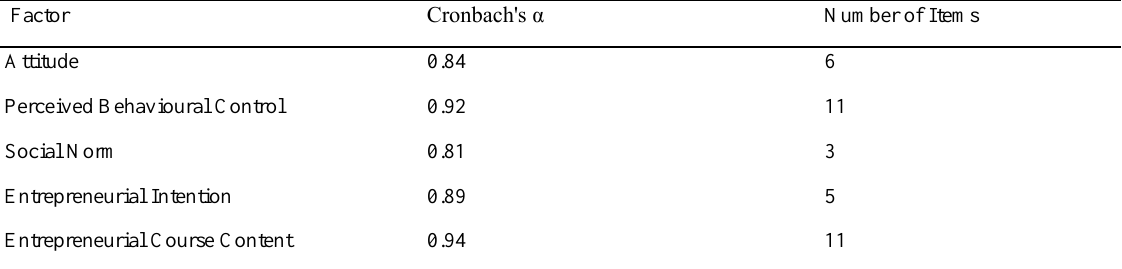
Table 1: Reliability Statistics for variables and the number of measurement